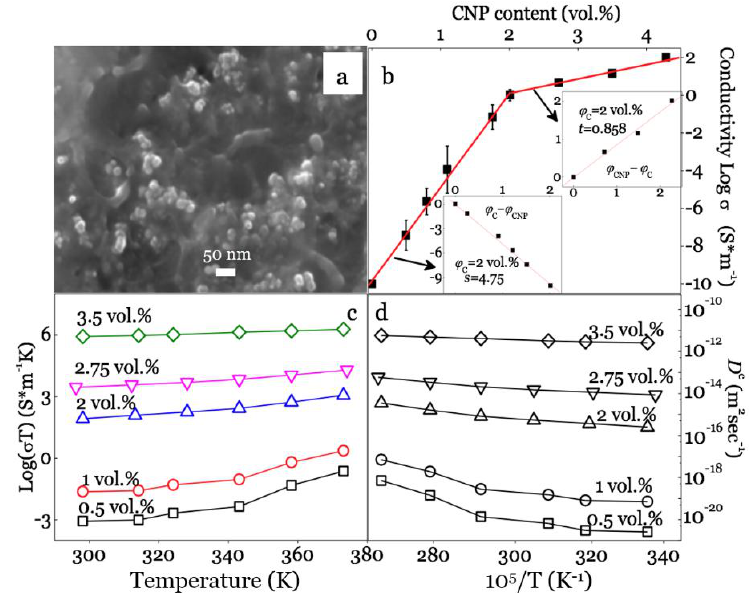
Figure 2. ( a ) Scanning electron microscopy (SEM) observation of the conductive surface for 2 vol. % CNP/PS; ( b ) DC conductivity results as a function of CNP content and the inset linear fitting curves needed for determining the threshold value; ( c ) DC conductivity for composites with dependency on temperature and CNP concentration; ( d ) calculated conductivity diffusion coefficients as a function of temperature.